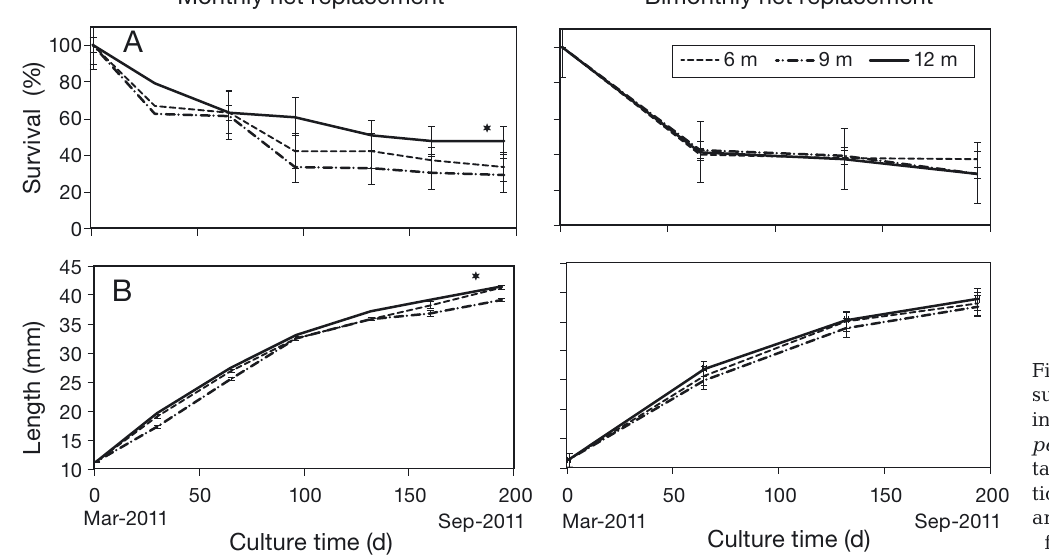
Fig. 1. Mean ± SE (A) survival and (B) growth in shell length of Argo - pec ten nucleus main- tainedatdifferentcondi- tions (i.e. culture depths and net re placement frequencies.